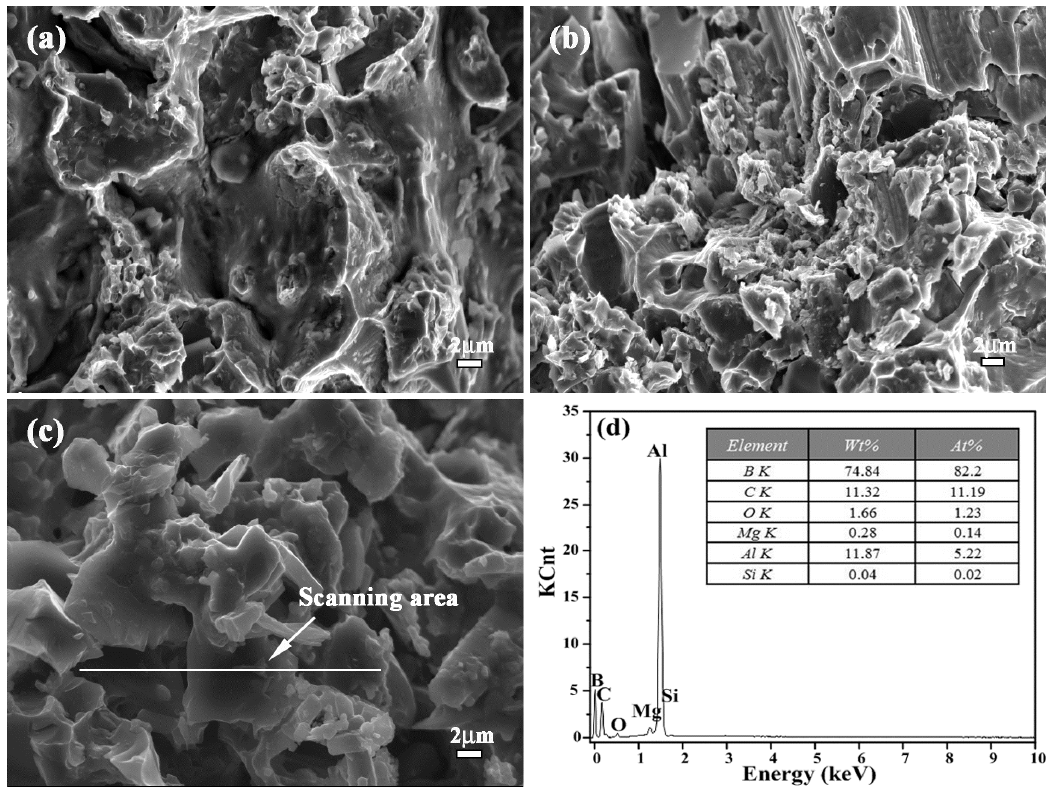
Figure 3. Fracture morphology of B 4 C/Al 5083 composite with ( a ) 10 wt % B 4 C content; ( b ) 20 wt % B 4 C content; ( c ) 30 wt % B 4 C content; ( d ) EDS analysis of ( c ).